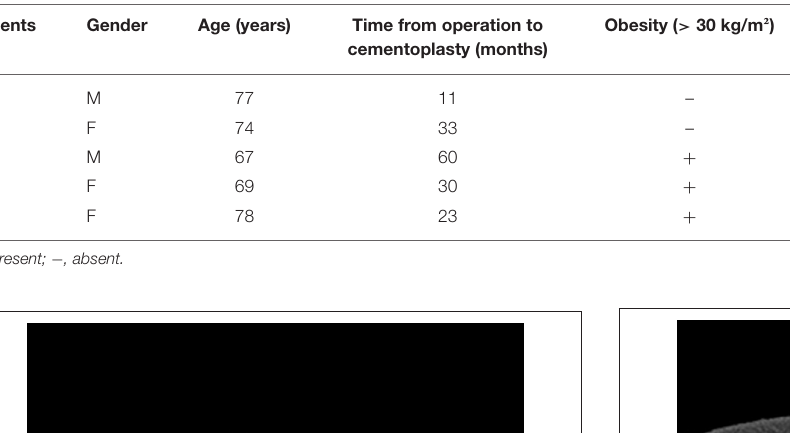
TABLE 1 | Patient’s characteristics.